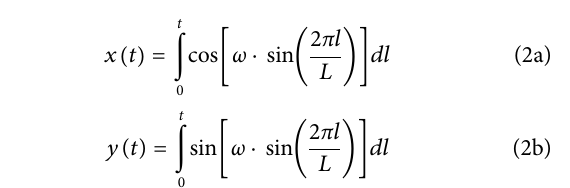
Frontiers in Energy Research |